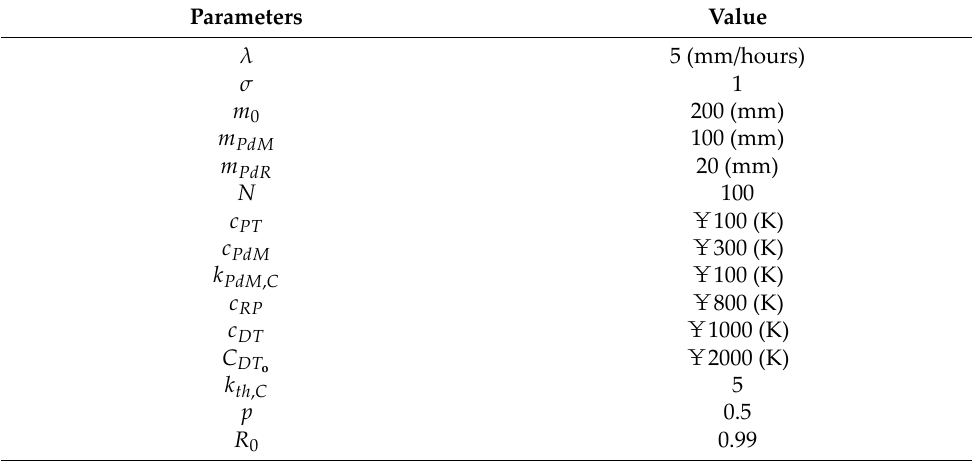
Table 1. Parameters in the numerical example.